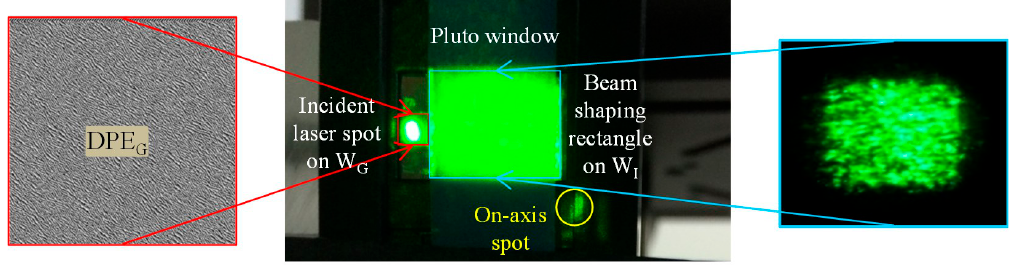
Figure 4. Beam-shaping rectangle (green) with a size the same as that of image sub-window W I .